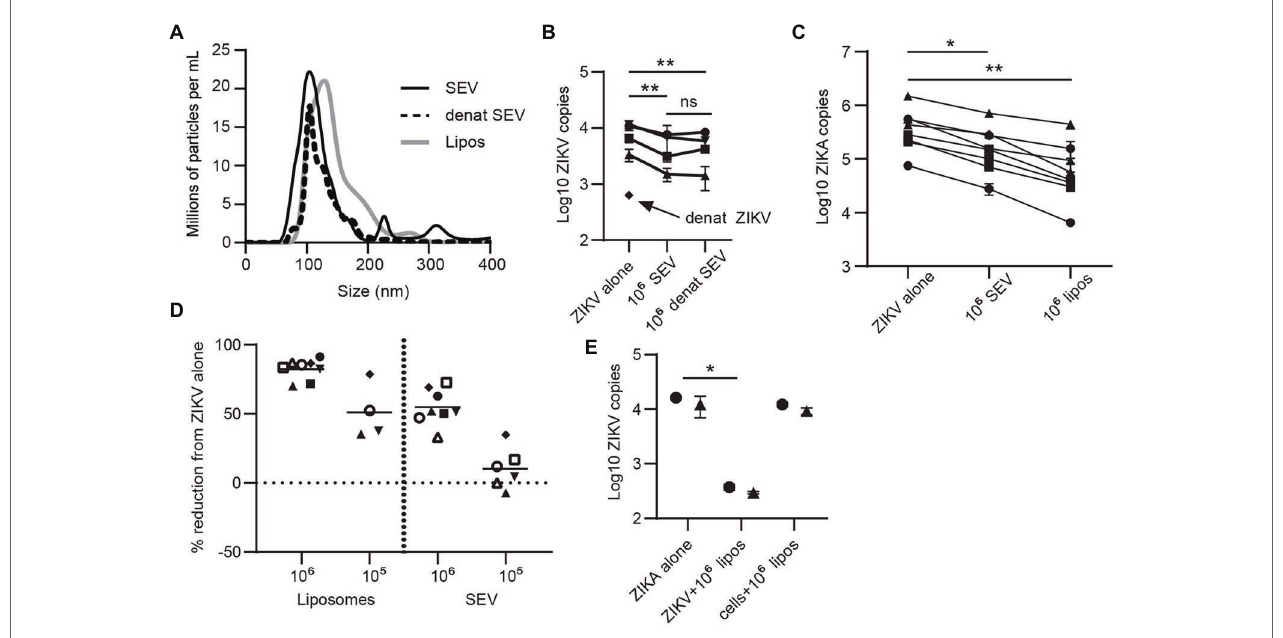
FIGURE 4 | Lipid content of SEV blocks ZIKV infection. (A) The protein content of SEV was denatured by heating at 95 ° for 8 min. Nanoparticle tracking analysis (NTA) profile comparing heat-treated and untreated SEV showing that the size profiles do not change. Size profiles of liposomes (see part C) are also plotted. (B) Equal amounts of heat-treated or untreated SEV were incubated with ZIKV virions at a 10 6 SEV:PFU, then added to epithelial cell lines for 1.5 h before washing and assessing ZIKV binding by ddPCR. As a control, ZIKV virions were also heated at 95 ° for 8 min. Each line is a separate cell line, points are mean of two replicate wells and error bars are standard deviation. Significance by one-way ANOVA with Tukey’s multiple comparisons test. ** p > 0.01. (C) ZIKV was pre-incubated with 10 6 SEV or 10 6 liposomes for 1 h prior to infecting genital epithelial cells. Seventy-two hours post-infection cells were lysed and ZIKV genomes quantified by ddPCR. Each line is the average of duplicate wells from a separate experiment. Reduction in ZIKV genomes was significant by one-way ANOVA with Dunnett’s multiple comparisons test. * p < 0.05, and ** p < 0.005. (D) The data from C , and additional conditions with 10 5 SEV or liposomes, are plotted as percent reduction from ZIKV alone. Each symbol represents the average of two technical wells from a different cell line. The horizontal lines are the mean for each condition. (E) Comparison of pre-incubation of either ZIKV or epithelial cells with liposomes on viral infection. Liposomes were pre-incubated with ZIKV (ratio:10 6 liposome per PFU) or with cells (same amount of liposomes) for 1 h at 37 ° , then virus was added to cells for 1.5 h. Cells were washed and cell-associated ZIKV genomes quantified by ddPCR. Each symbol represents the average of two technical replicates from different epithelial cell lines. Significance by one-way ANOVA with Dunnett’s multiple comparisons test. * p <